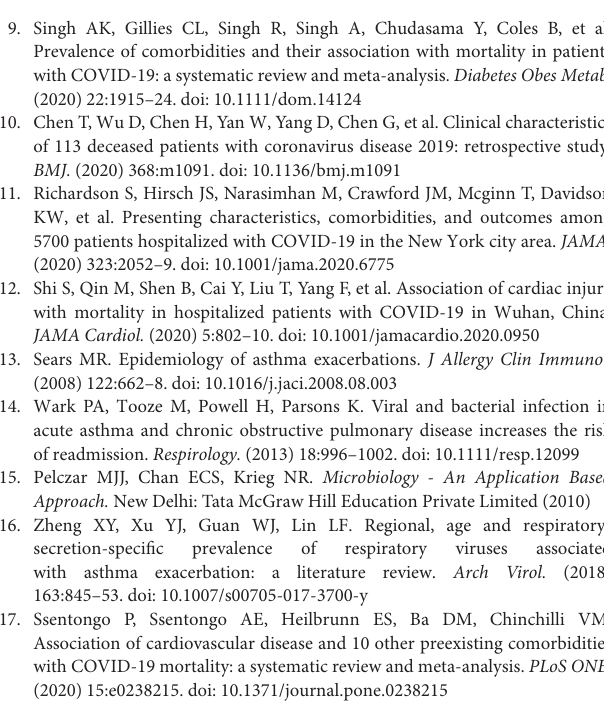
Supplementary Figure 1 | Sensitivity analysis of mortality. Supplementary Figure 2 | Sensitivity analysis of ICU admission. Supplementary Figure 3 | Sensitivity analysis of hospitalization. Supplementary Figure 4 | Funnel plot of mortality. Supplementary Figure 5 | Funnel plot of ICU admission. Supplementary Figure 6 | Funnel plot of hospitalization. Supplementary Table 1 | The quality assessment of included studies. Supplementary Table 2 | Publication bias of included studies. Supplementary Table 3 | Literature search and study